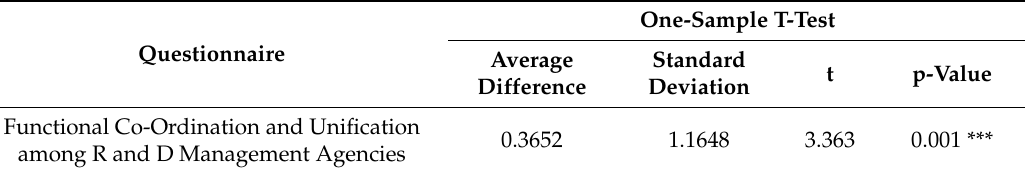
Table 6. Functional co-ordination and unification among R and D management agencies.